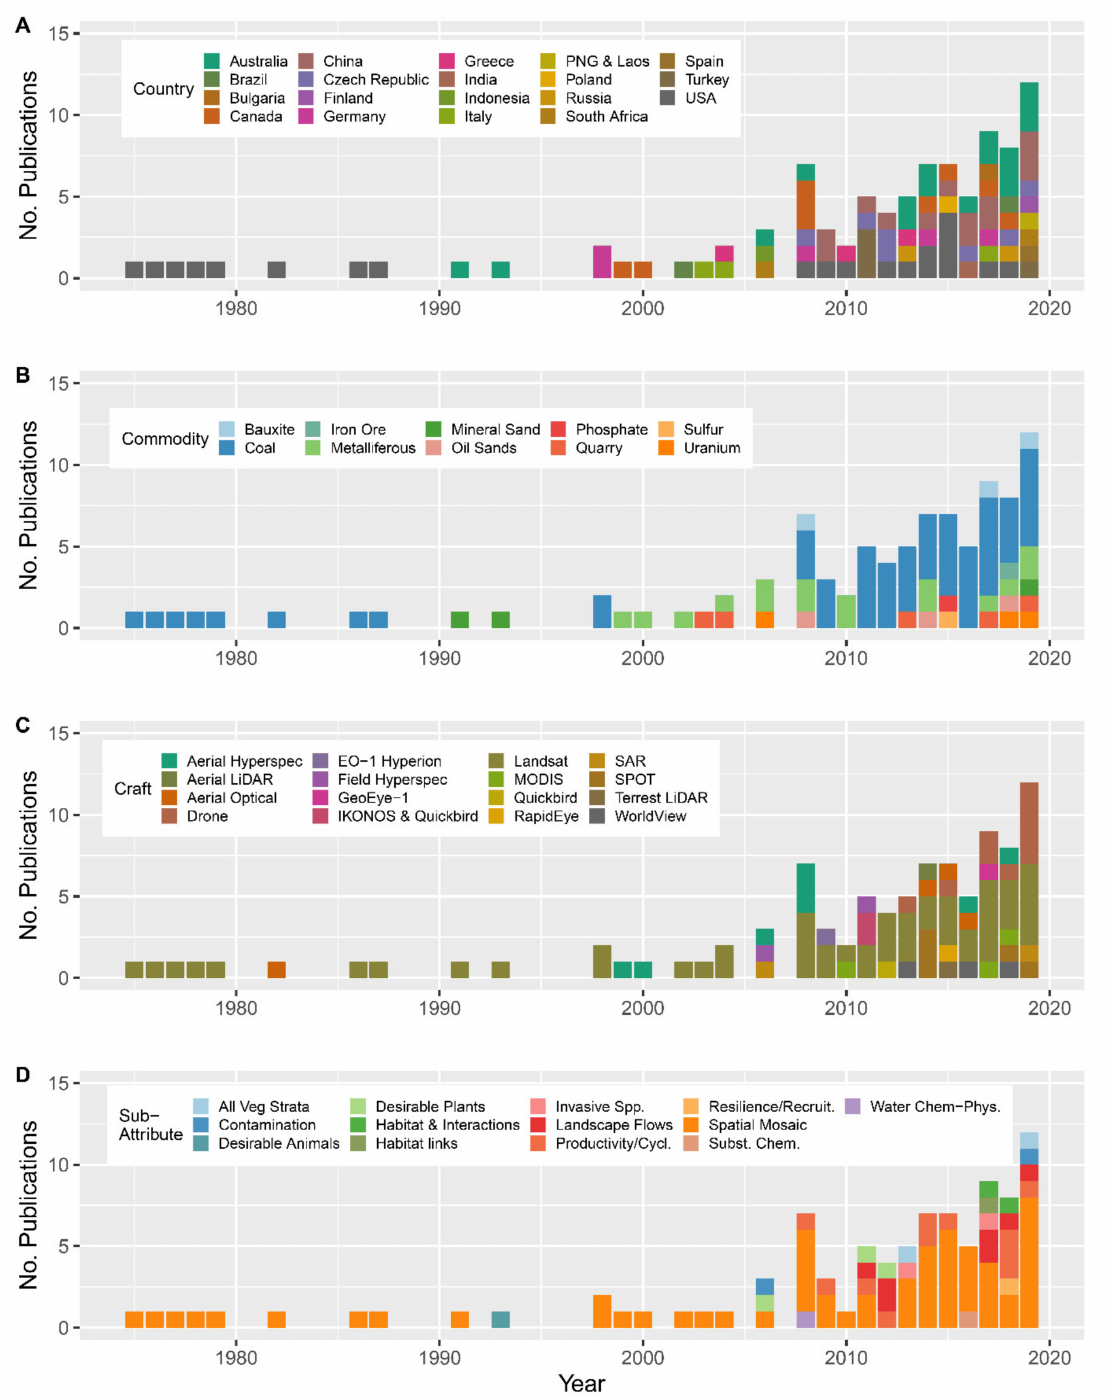
Figure 1. Stacked bar charts showing the number of publications for each year, according to the country of study ( A ), the commodity ( B ), the primary craft used for the assessment ( C ), and the sub-attributes taken from the SER ecological recovery wheel ( D